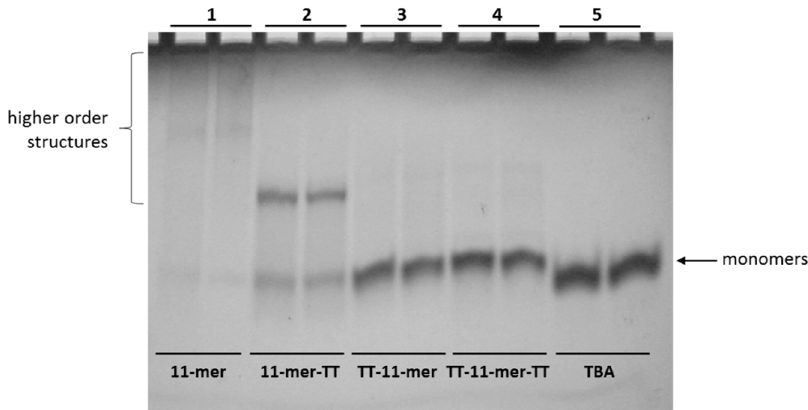
Figure 1. Polyacrylamide gel electrophoresis analysis of 11-mer and its derivatives. Lane 1: 11-mer; lane 2: 11-mer-TT; lane 3: TT-11-mer; lane 4: TT-11-mer-TT; lane 5: TBA. Each oligonucleotide was analyzed in duplicate.